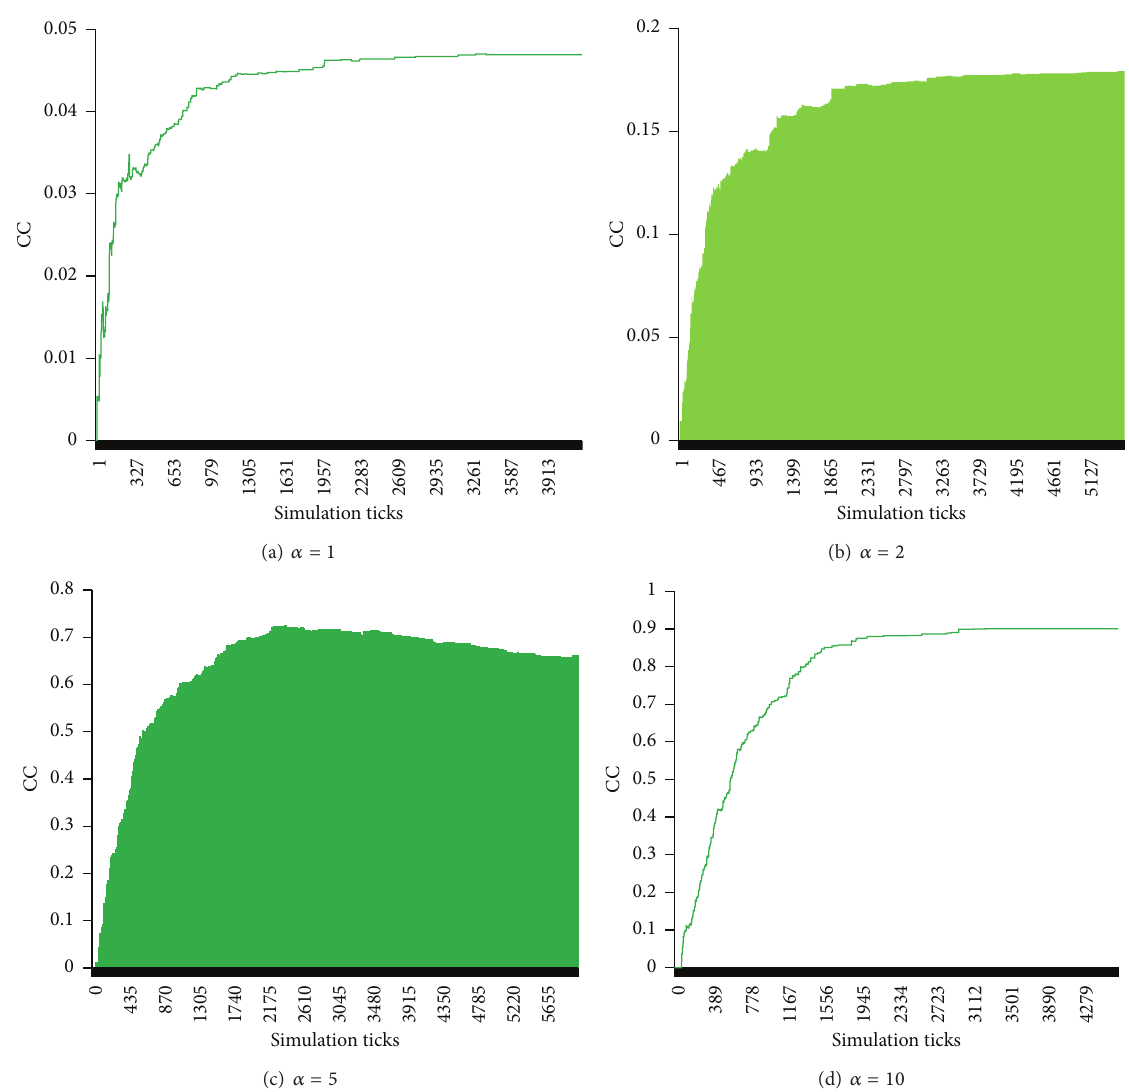
Figure 3: The clustering coefficient with different values of 𝛼 , where 𝛽 = 10 , 𝑚 = 5 , 𝜅 = 0.00005 , 𝑝 1 = 1 , and 𝜆 = 0.3